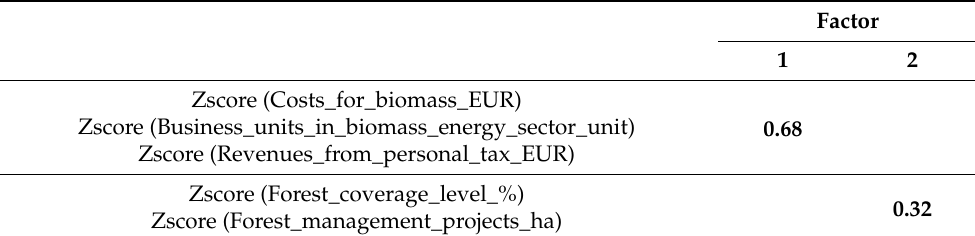
Table 9. Quadratic factor load (reduced to a single amount) for biomass energy sector indicators.